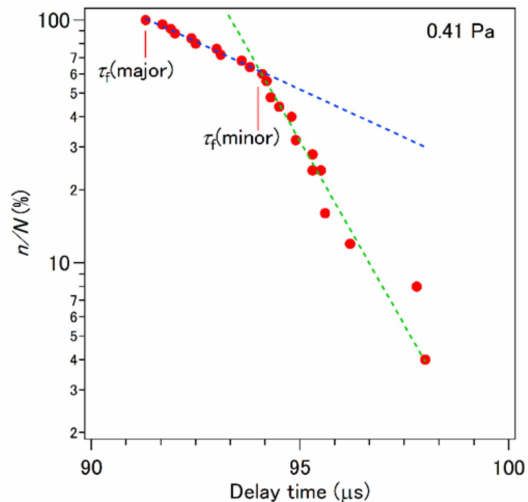
Figure 7. Typical Laue plot for the electrical breakdowns at 0.41 Pa for the working pressure and at V s = − 528 V (red solid circles). The fitting results ( n/N [%]) = 100 e − ( t − 91.4 [ µ s])/5.51 [ µ s] as a major discharge component and 61.5 e − ( t − 94.0 [ µ s])/1.44 [ µ s] as a minor discharge component for N = 25 are indicated by the blue and green dashed lines, respectively. The times ( τ f ) of major and minor discharges are also